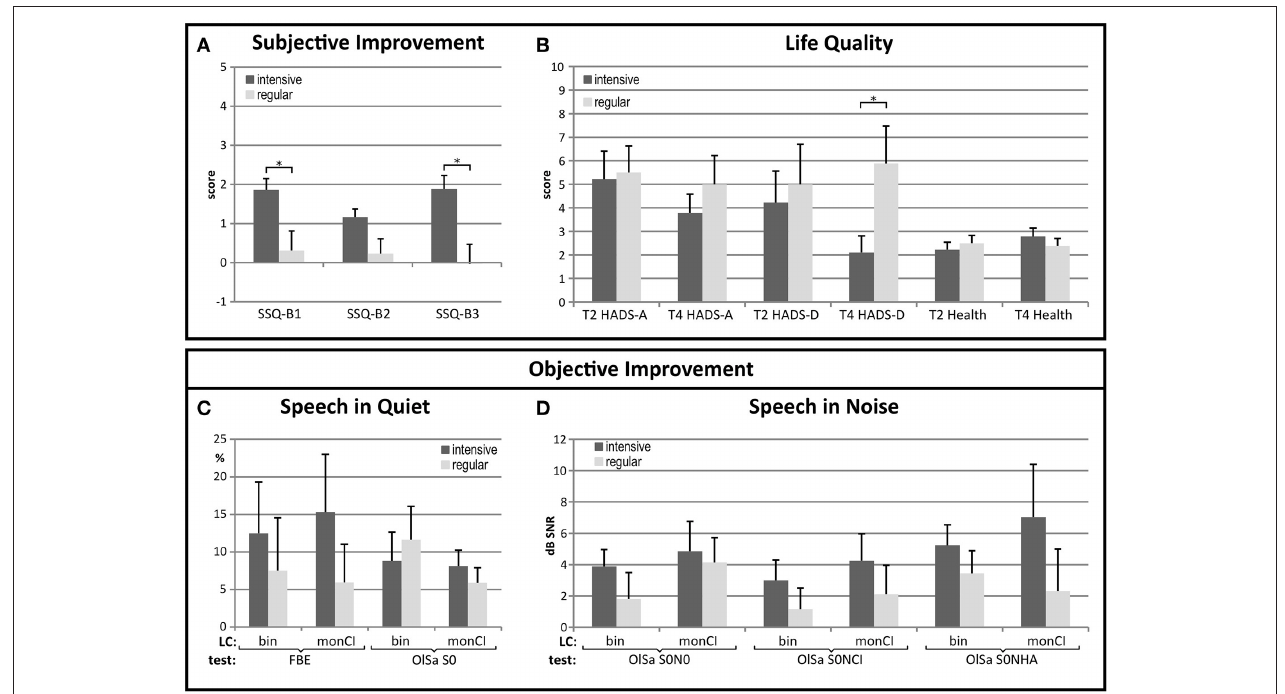
FIGURE 3 | Improvement of self-reported auditory abilities, life quality and audiometric measures in the groups with intensive and regular CI-rehabilitation. (A) Subjective improvements for speech comprehension (SSQ-B1) and sound quality (SSQ-B3) were significantly better in the group with intensive CI-rehabilitation. (B) The level of depression which did not differ between groups at T2 reached a significantly higher level in the group with regular rehabilitation at T4 (* p < 0.05). Improvements for all but one of the speech comprehension tests (C , D) were better in the group with intensive rehabilitation, but differences did not attain statistical significance. Bin: binaural, FBE: monosyllable test, HADS-A: anxiety, HADS-D: depression, LC: listening condition, monCI: monaural CI-assisted listening, SSQ-B1-3: scores for self-perceived improvement of speech, spatial and sound quality, T2: pre-surgery, T3: 3 months post-implantation, T4: 6 months post-implantation, statistically significant difference: (* p <